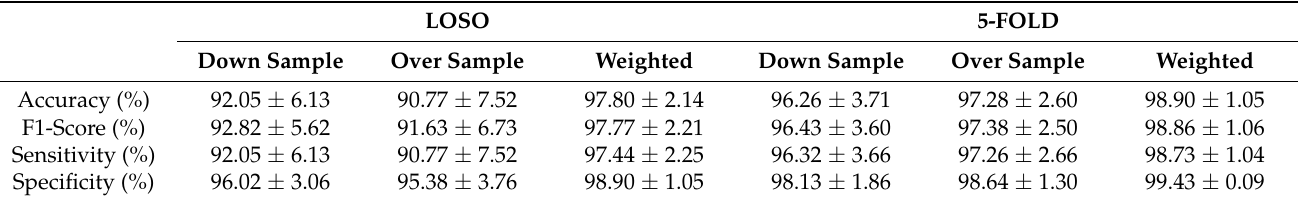
Table 1. Performance metrics for I3D